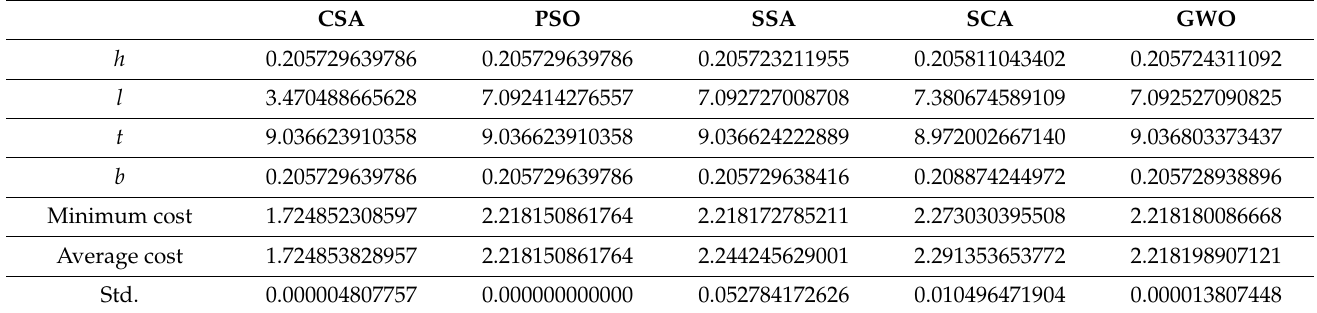
Table 12. Optimal design of welded beam.